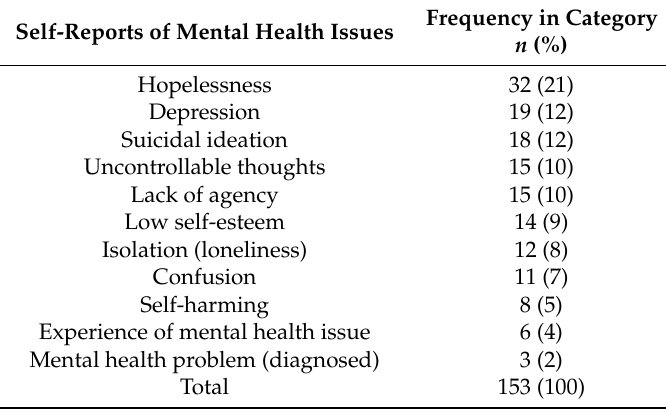
Table 4. Self-Reports of mental health